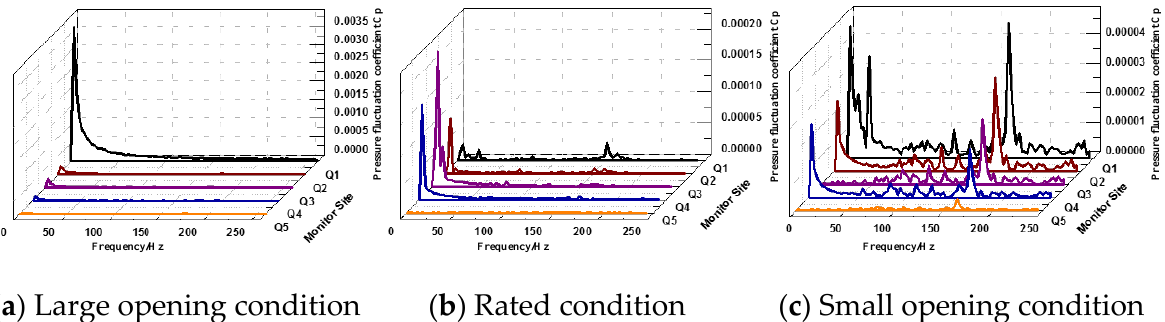
Figure 7. Outlet pressure pulsation frequency domain diagram.